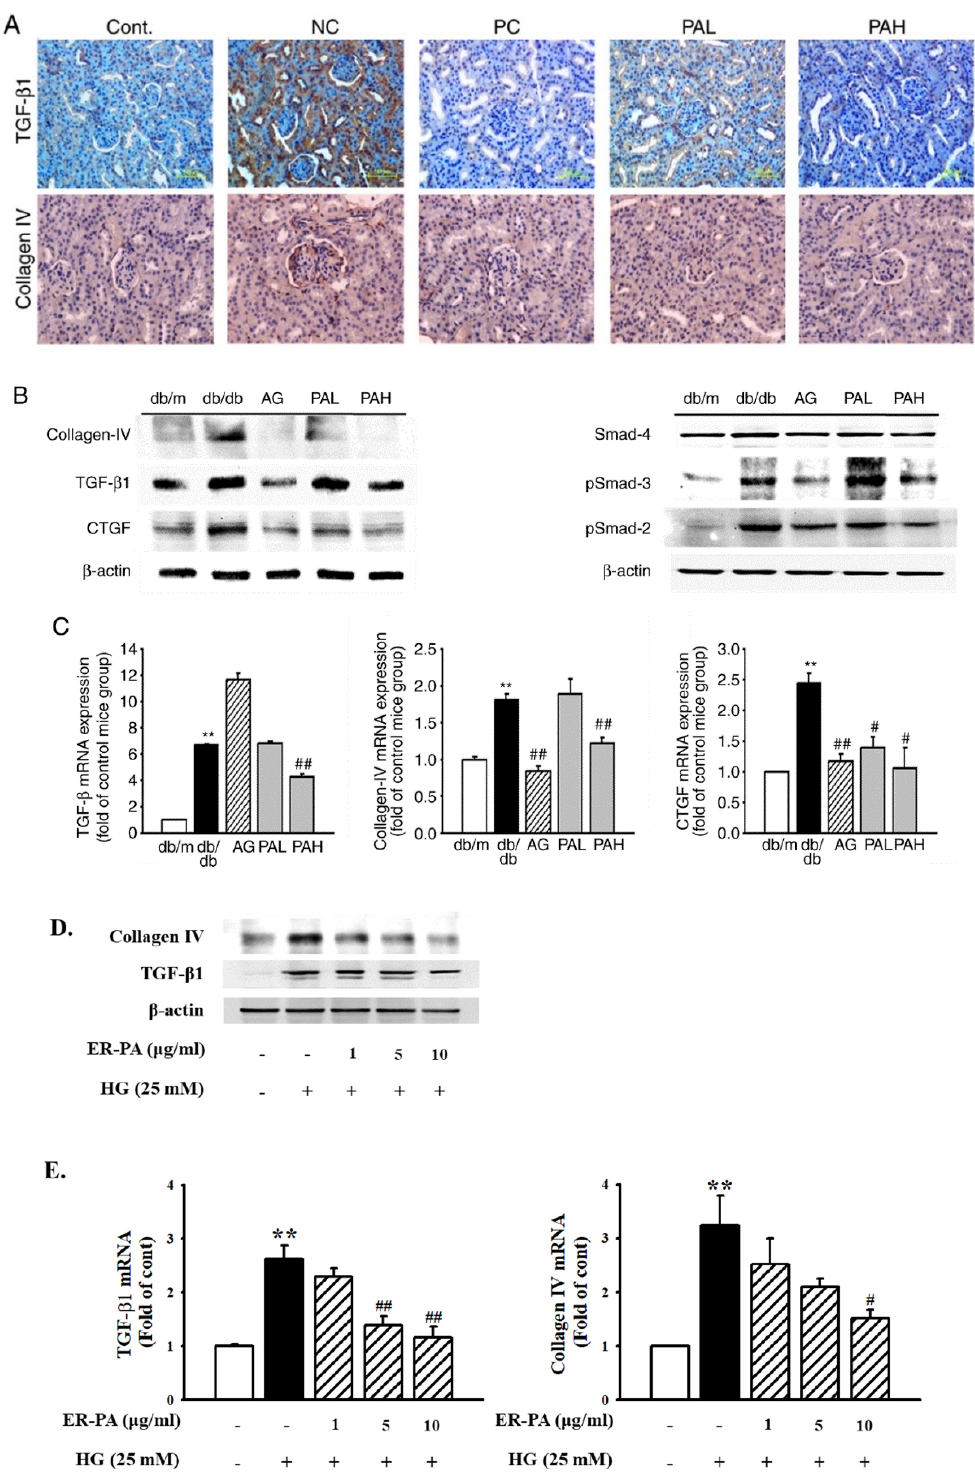
Figure 6. Effect of ER-PA on renal fibrosis. ( A ) Immunohistochemistry analysis showed that ER-PA therapy inhibits TGF- β 1 and Collagen IV expression in the diabetic kidneys of db/db mice ( n ≥ 3; magnification, × 200); ( B ) Expression of protein was determined with western blot analysis ( n ≥ 3); ( C ) Expression of mRNA was determined by reverse transcription-quantitative PCR analysis ( n ≥ 5). Values are expressed as mean ± standard deviation ( n = 8). ** p < 0.01 vs. db/m; # p < 0.05,